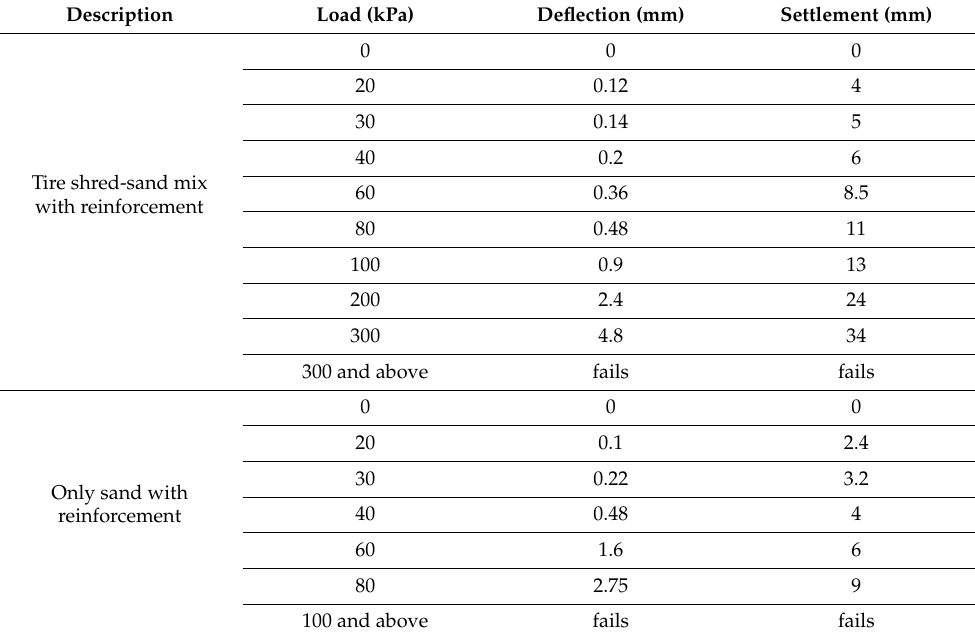
Table 5. Comparative values of tire shred-sand mixture with reinforcement and only sand with reinforcement from Plaxis 3D.